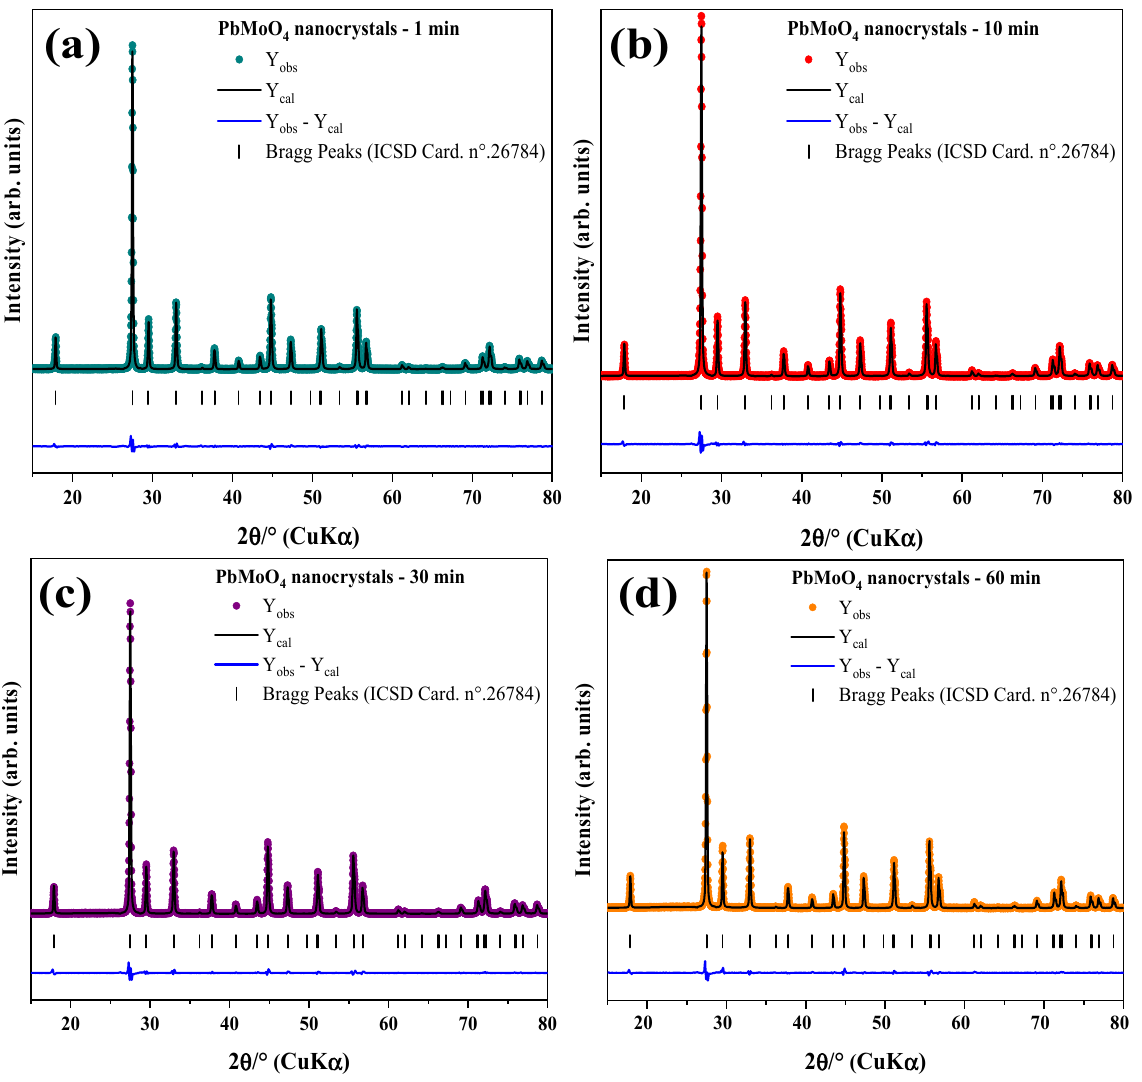
Figure 2. Rietveld refinement of the PbMoO 4 nanocrystals obtained from the MH method: ( a ) PbMoO 4 -1, ( b ) PbMoO 4 -10, ( c ) PbMoO 4 -30 and ( d ) PbMoO 4 -60.